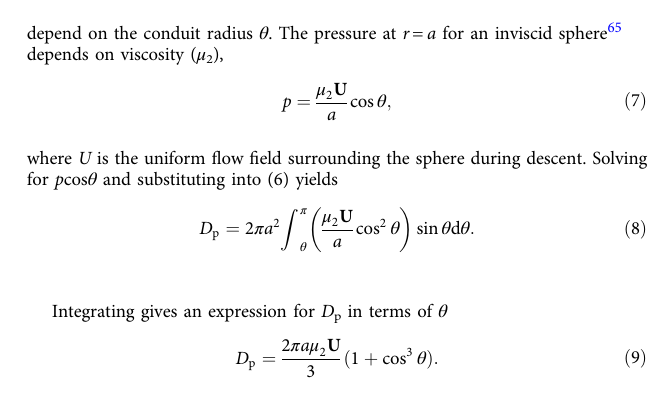
Fig. 8 Interior schematic of iron diapir descent and rise of thermochemical plumes. a depicting the descent of a metal − silicate diapir (stage 1) from an emulsi fi ed metal pond, second-stage descent of remaining metal droplets (stage 2) and b ascent of a thermochemical plume (stage 3) and ascent of late stage plumelets (stage 4) from a metal pile at the base of the